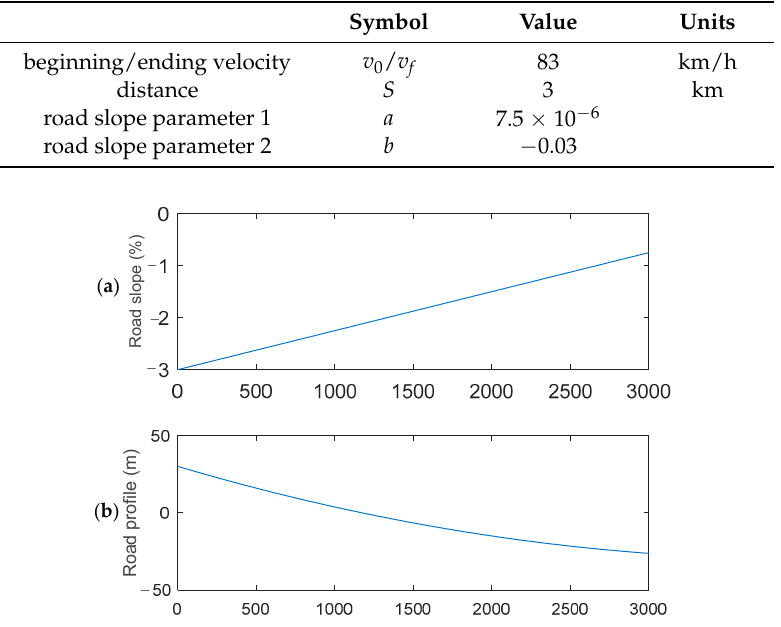
Figure 9. Optimum speed profile and its corresponding control inputs; time factor σ = 0~38, duration t f = 107 s/107 s. ( a ) Speed profile; ( b ) control input profile.